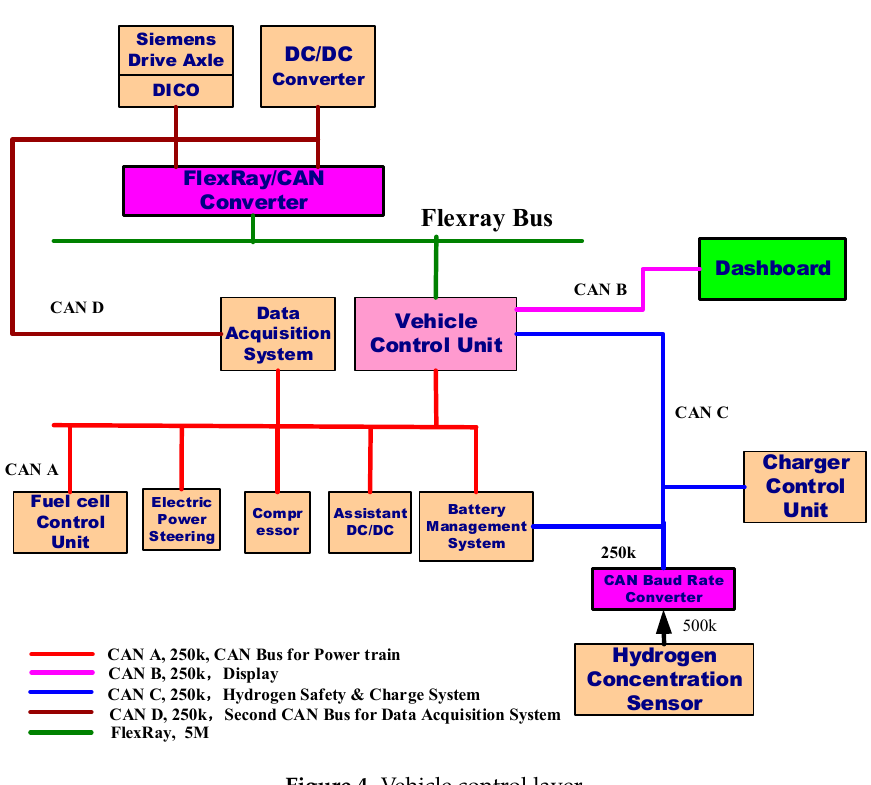
Figure 4. Vehicle control layer.